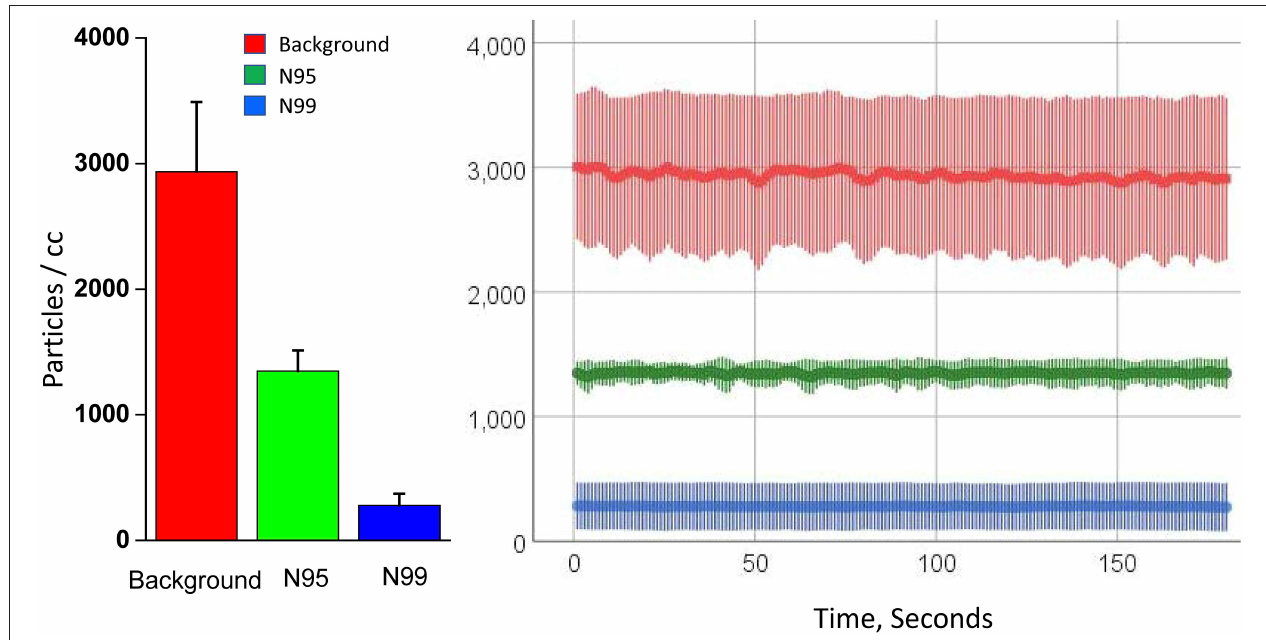
FIGURE 2 | Mean and standard deviation of data for the last 3-min are shown on the panel for the background condition (no mask) and the N95 and N99